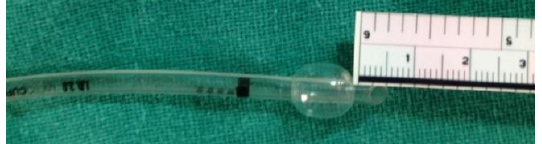
Figure 1: 3.0mm ID METT with Cuff position 5mm from the distal